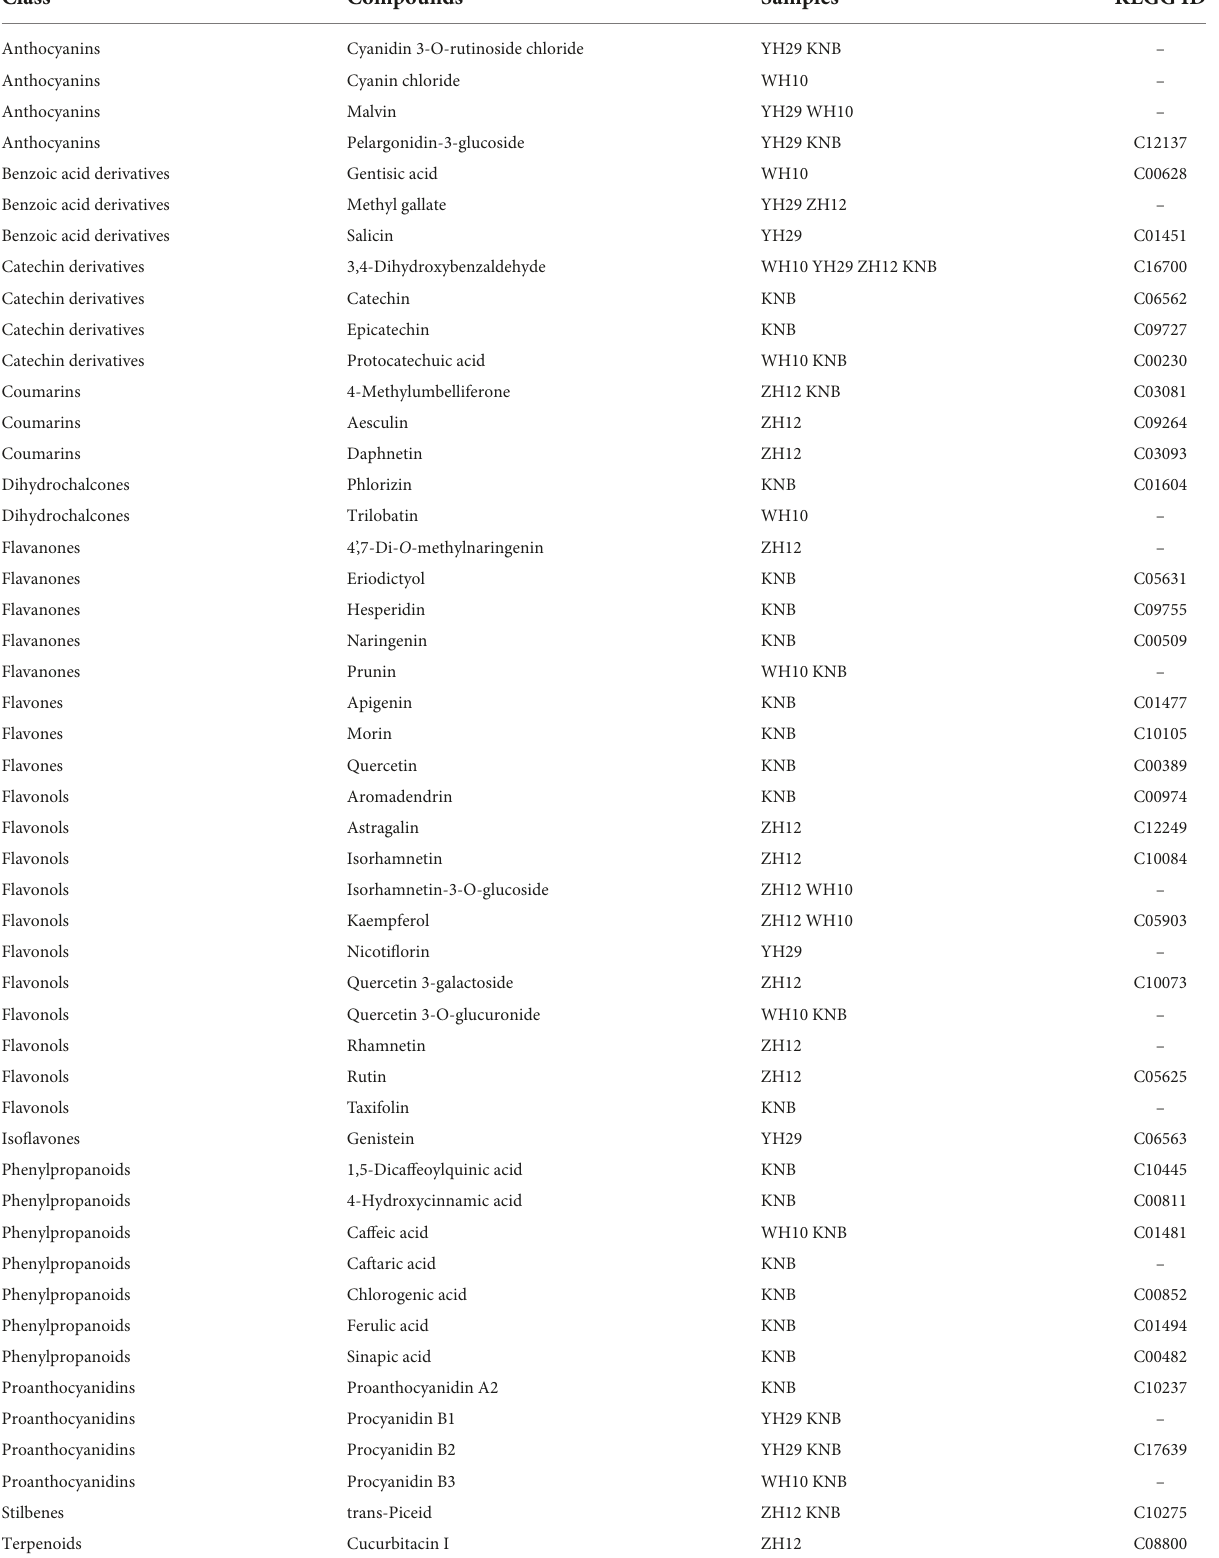
TABLE 1 Key 49 significantly differential metabolites between the different colored